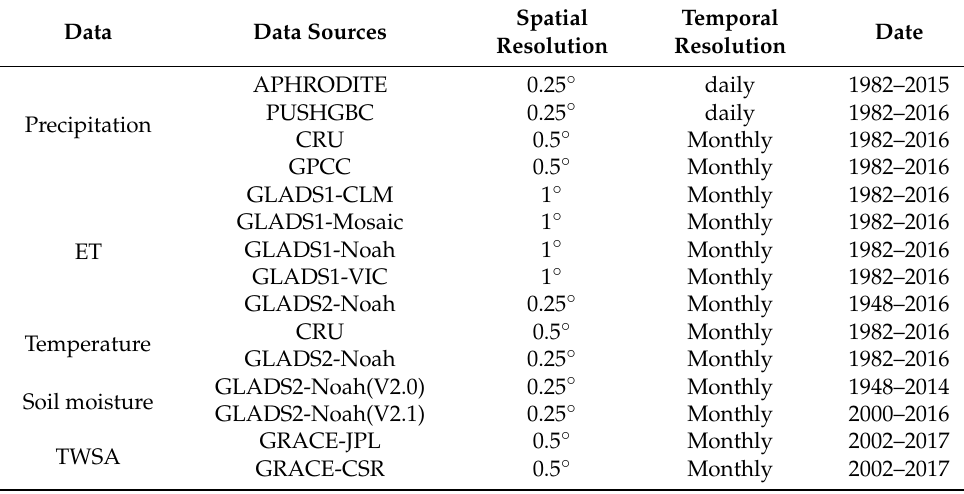
Table 2. Brief Description of Datasets